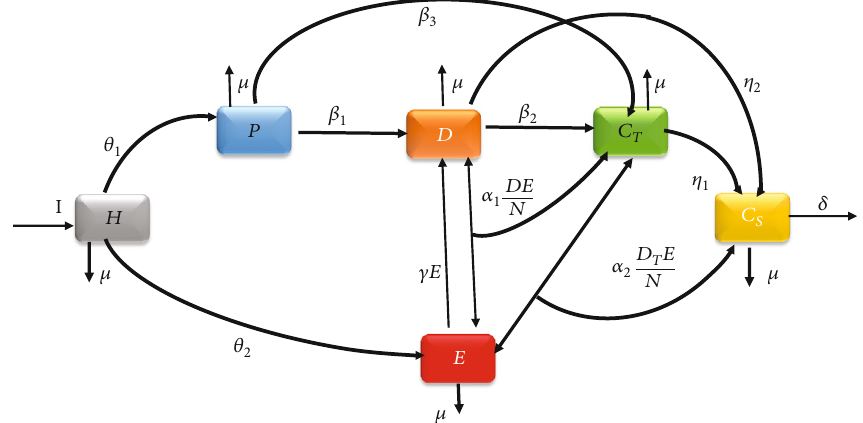
Figure 1: The dynamics of a population of